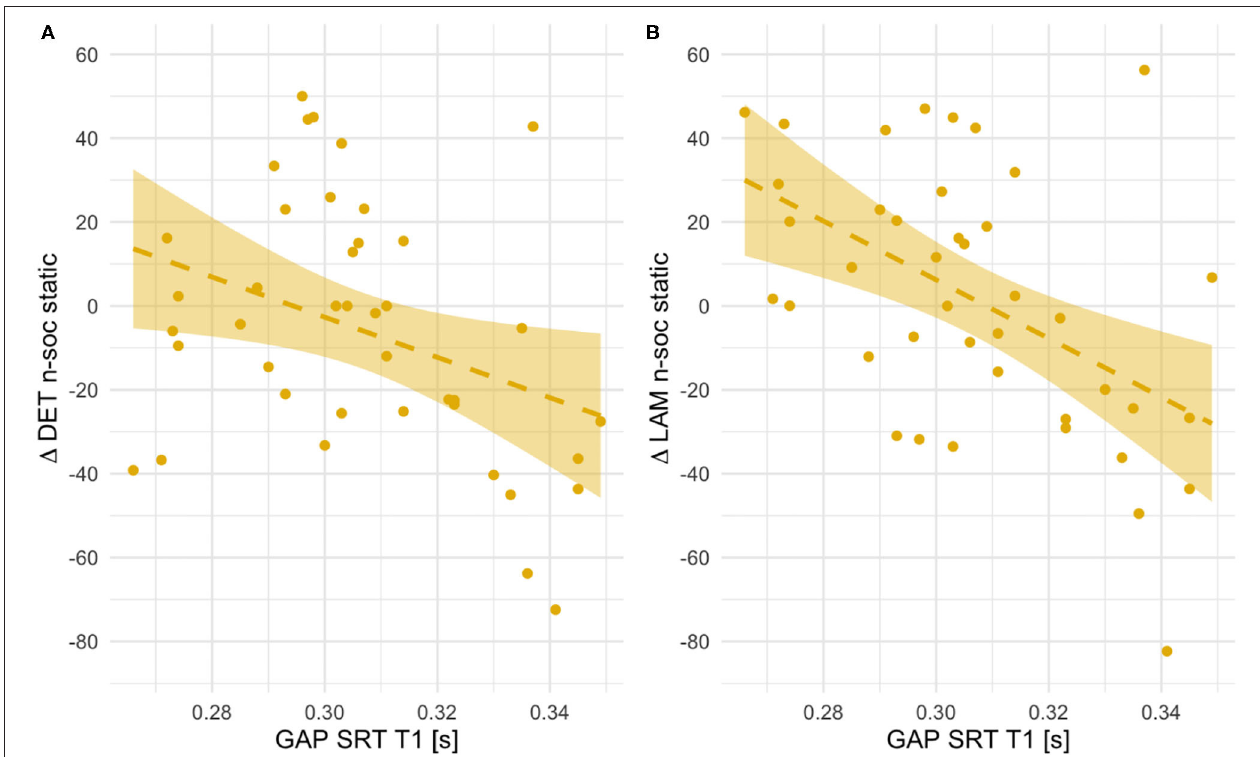
FIGURE 8 | Scatterplots showing associations between orienting speed at T1 (saccadic reaction times in the gap condition) and within-subject age-related change in Determinism (A) and Laminarity (B) for non-social static stimuli (T2–T1 values, thus positive indicate an increase with age and negative values - a decrease). Fit line represents the regression line (with 95%